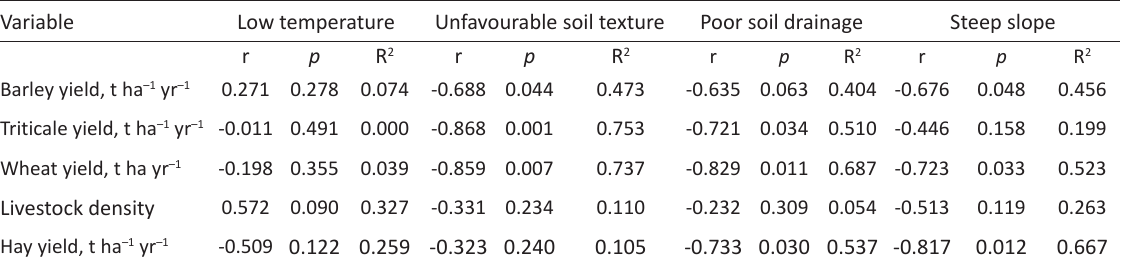
Table 5. Correlation (r) and determinant (R 2 ) coefficients between crop yields, livestock density and variables selected as LFAs indicators